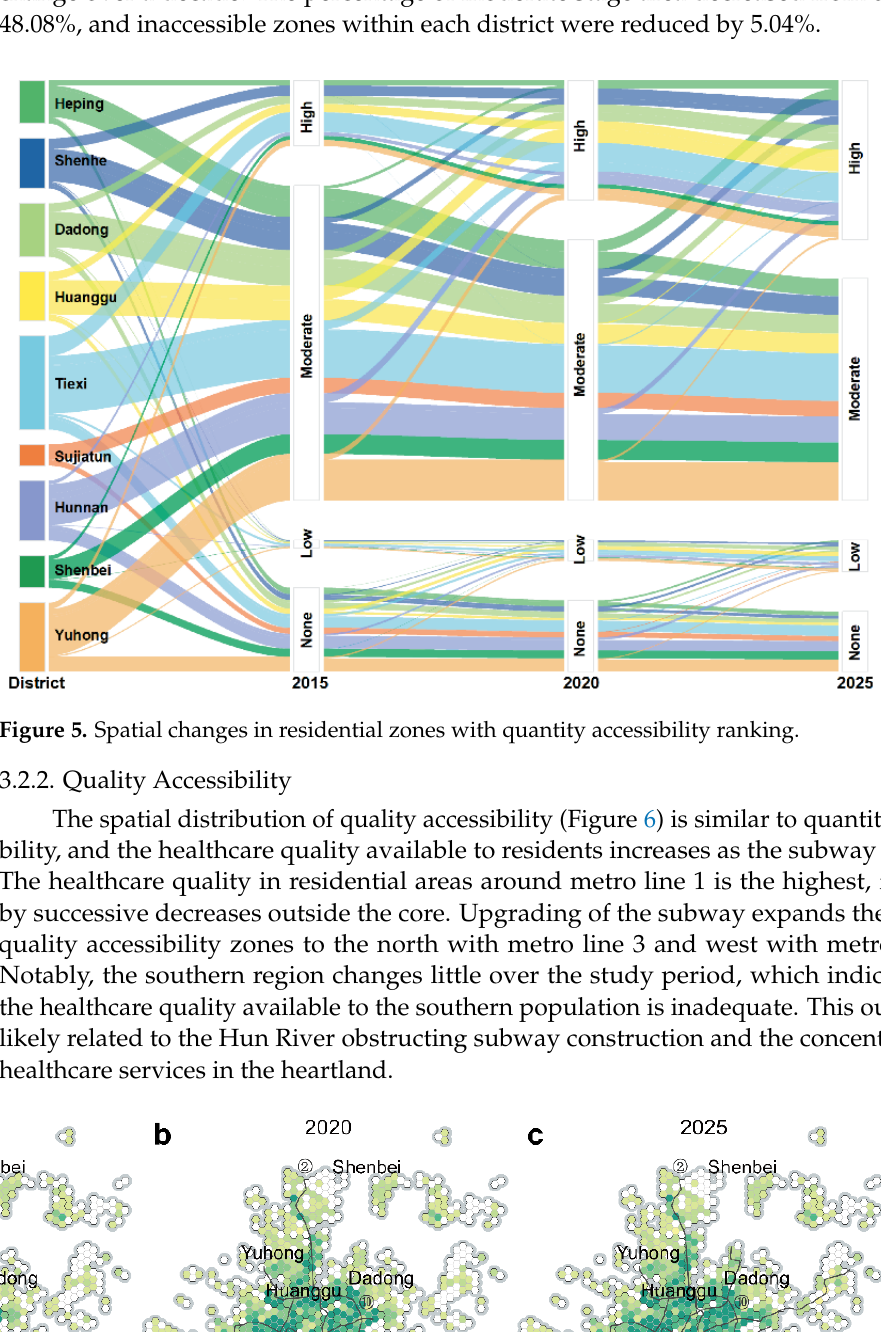
Figure 4. Spatial quantity accessibility to healthcare services at different stages of subway system development: ( a ) accessibility in 2015; ( b ) accessibility in 2020; ( c ) accessibility in 2025.